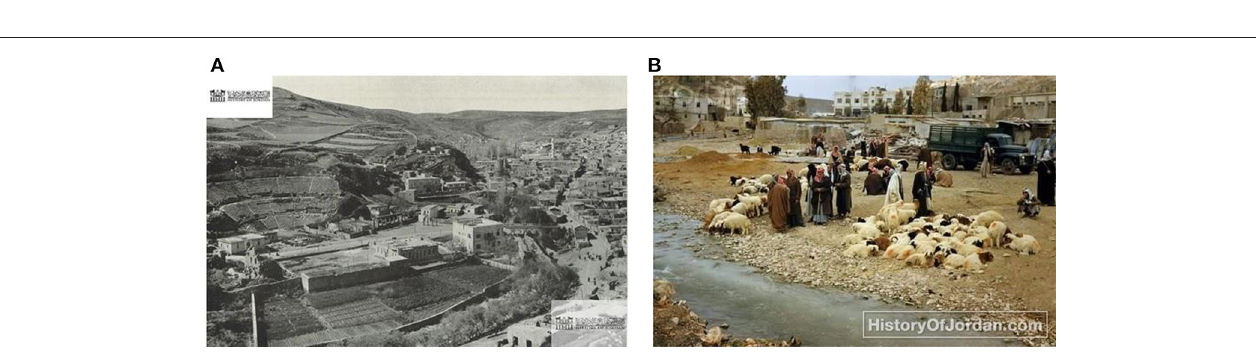
FIGURE 7 | The total area of the Amman Stream, the building footprints, and the urban blocks during the years 1953, 1978, 1992, 2000, and 2018 (150-m buffer on both sides of the Amman Stream).